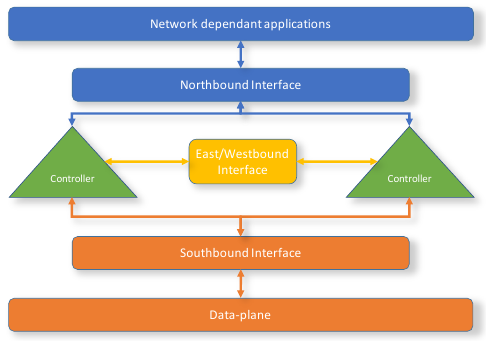
Figure 2. Software-defined network components